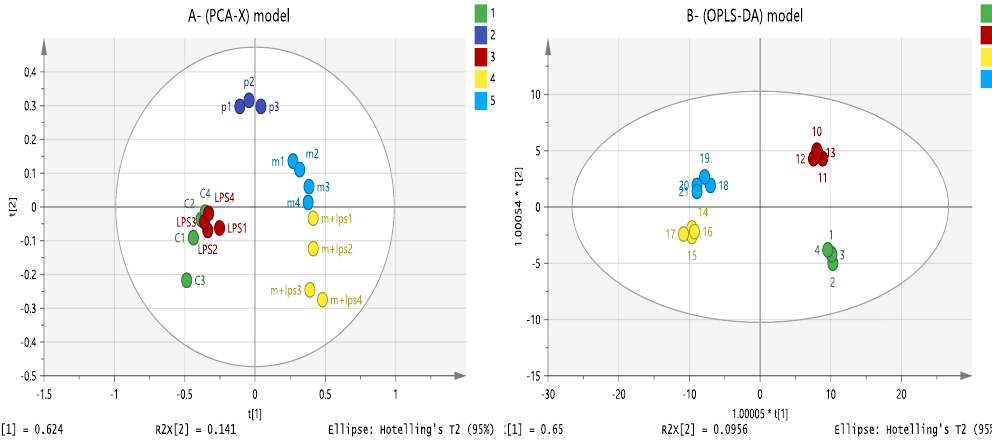
Figure 7. ( A ) PCA-X vs. ( B ) OPLS-DA score plots of THP-1 cells. The figures show a clear separation between control, pooled and treatment groups (LPS, melittin and LPS + melittin) based on 128 significant non-polar metabolites separated on an ACE C4 column ( n = 4). PCA score plot ( A ) has R 2 X = 0.867 , Q 2 = 0.753. OPLS-DA score plot ( B ) has R 2 X = 0.896, R 2 Y = 0.978, Q 2 = 0.895. (C: control; Mel: melittin; LPS: lipopolysaccharide; Mel + LPS: melittin and LPS combination treatments; P = pooled samples).